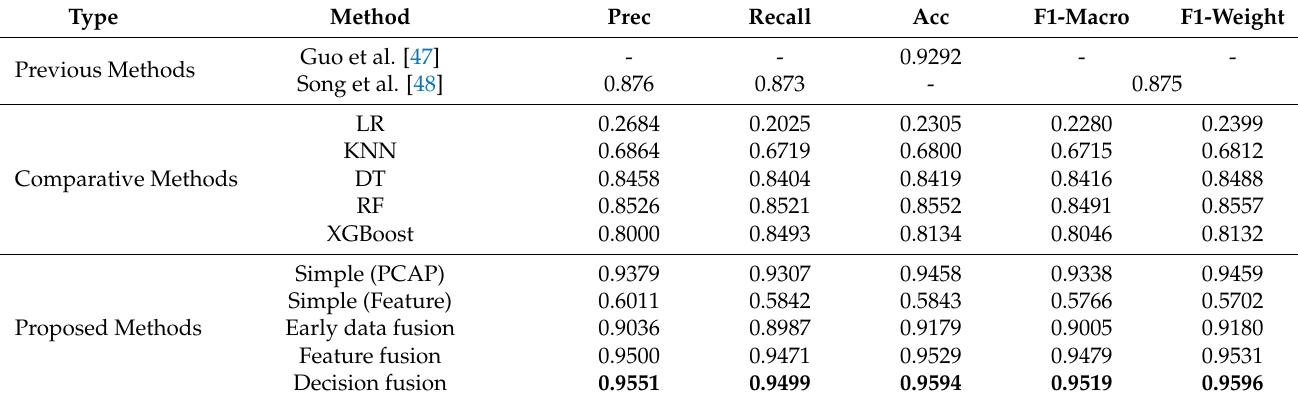
Table 5. Experiment results and comparation of data VPN2016.